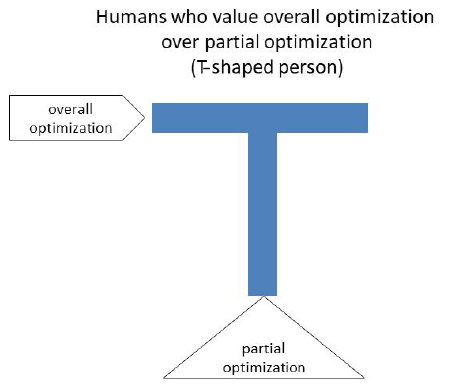
Figure 1. The image of T-shaped person